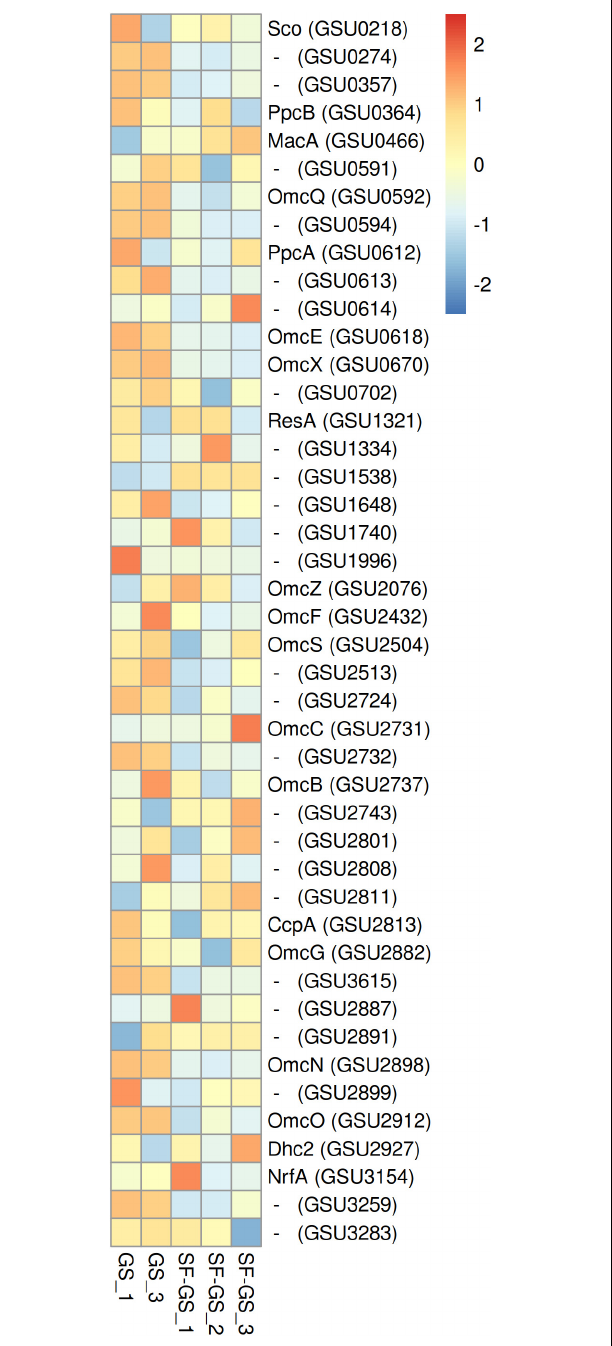
FIGURE 7 | cytochrome c peroxidase (MacA), cytochrome c (GSU0591), lipoprotein cytochrome c (OmcQ), cytochrome c (GSU0594), ResB-like family cytochrome c biogenesis protein (GSU0613), ResC/HemX-like cytochrome c biogenesis membrane protein (GSU0614), cytochrome c (OmcE), lipoprotein cytochrome c (OmcX), lipoprotein cytochrome c (GSU0702), apocytochrome c disulfide reductase lipoprotein ResA (ResA), cytochrome c